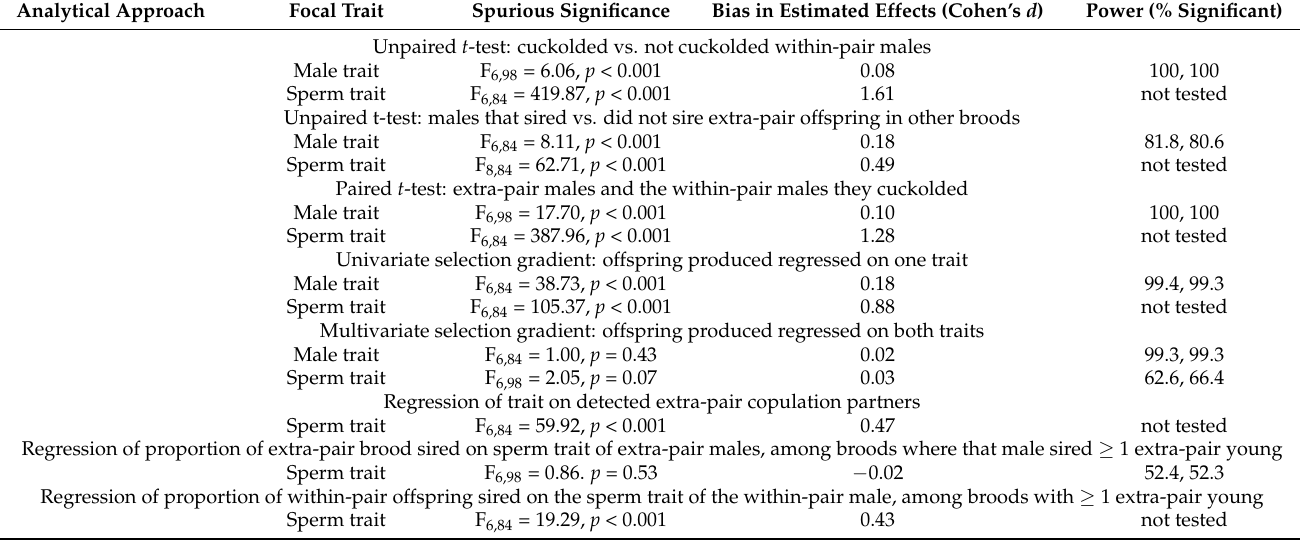
Table 2. Assessment of bias and relative statistical power for several analytical approaches for detecting selection on male and sperm traits. Spurious significance shows how, in individual populations where the trait is not impacting success, the male trait vs. sperm trait correlation affects the number of significant results (in the negative direction). The bias in estimated effects reflects how much the estimated effect (difference between groups or regression coefficient) changed due to selection on a correlated trait. Specifically, it gives the Cohen’s d effect size of the interaction between the male trait vs. sperm trait correlation and a variable identifying whether only the focal or both selective episodes were active. Relative power is approximated by the percent of significant results in the expected direction for populations with only the focal trait under selection or with both traits under selection. This is provided only for tests without substantial